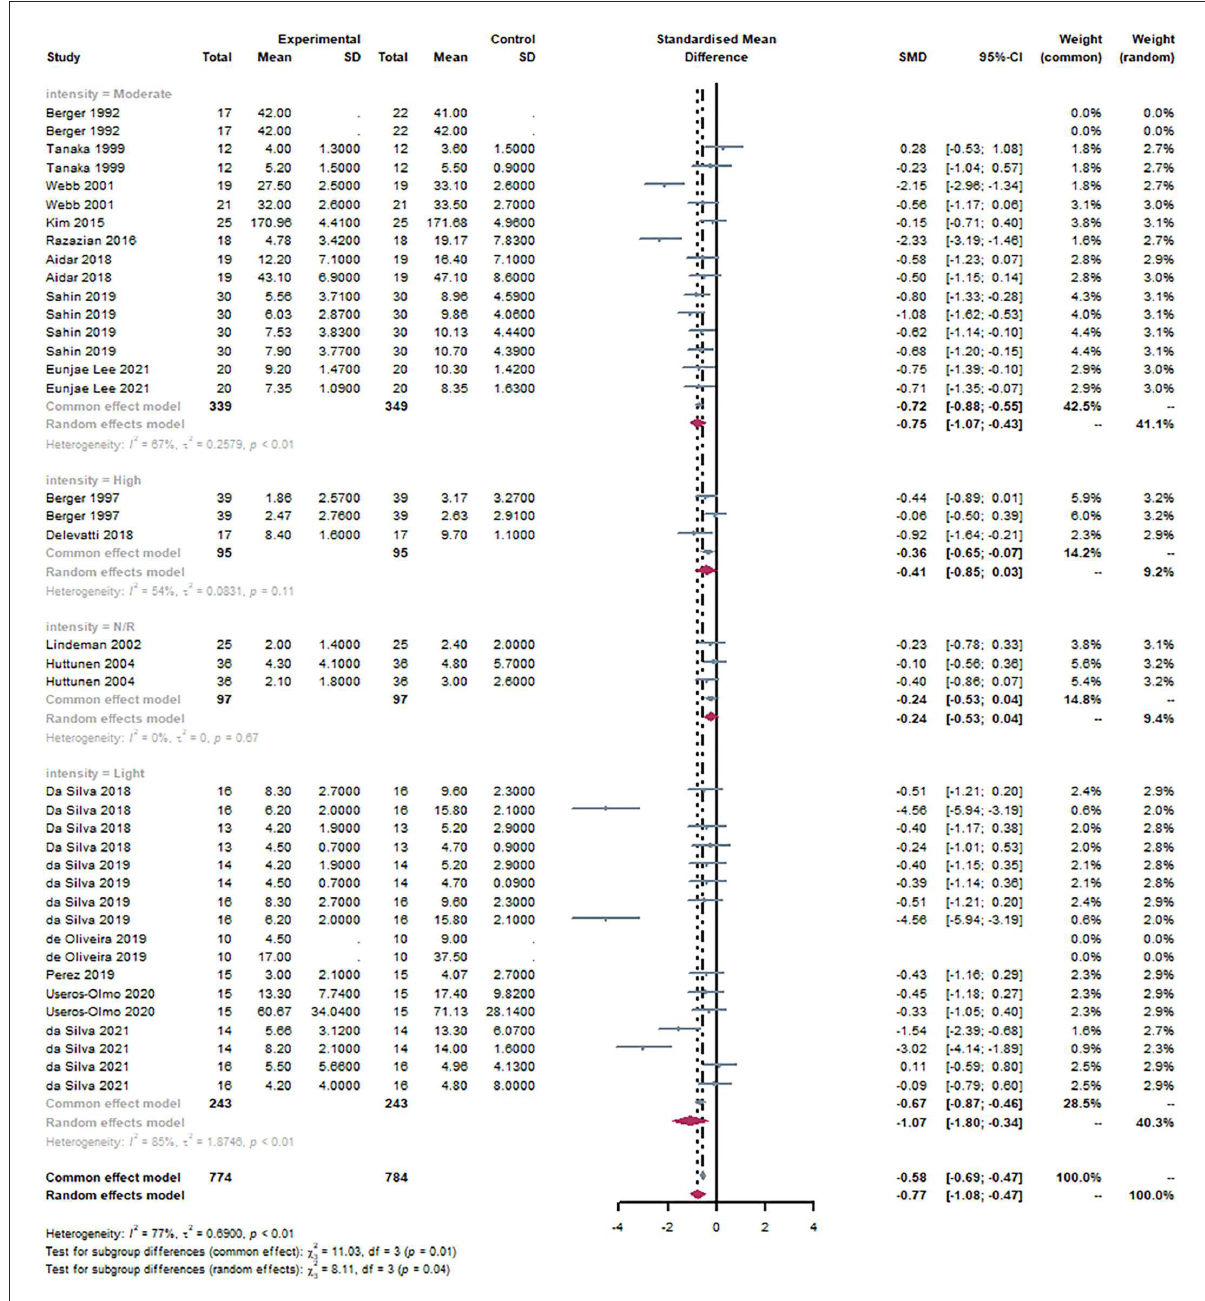
FIGURE10 Forest plot of the intensity of exercise. By subgroup analysis of the disease, moderate [SMD = − 0.75, 95% CI ( − 1.07, − 0.43), I 2 = 67%, P < 0.01] and light [SMD = − 1.07, 95% CI ( − 1.08, − 0.47), I 2 = 85%, P < 0.01] were statistically significant through the subgroup analysis.